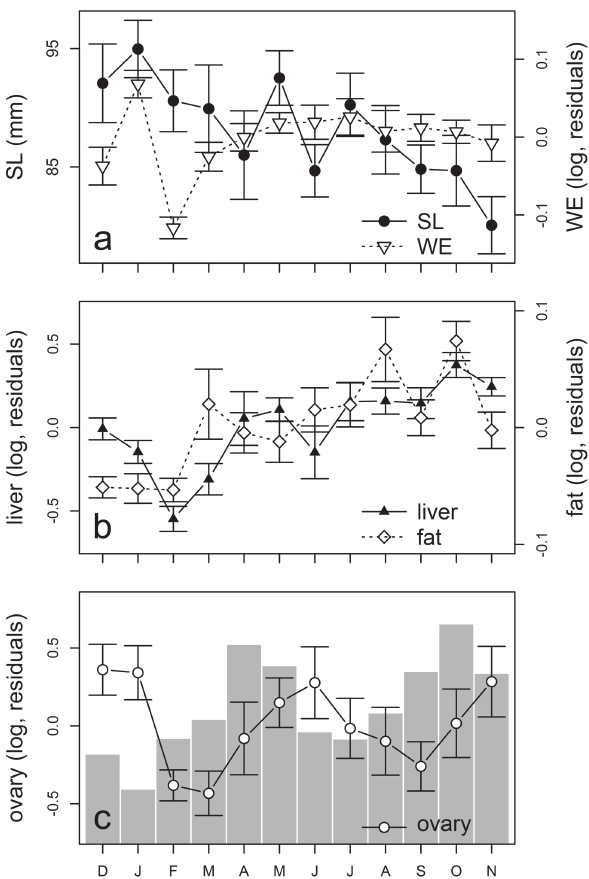
Fig. 2. Monthly variation in adult females: (a) SL, standard length and WE, eviscerated weight, (b) liver and fat weight, and (c) ovary weight. Barplot behind the lines represents the rainfall pattern. Table 1. Analysis of variance and covariance for monthly variation of log-transformed standard length (SL), eviscerated weight (WE), liver, fat, and gonad weights of females and males. Effect size measured as the partial η2. Significance of SL as covariate Significance of grouping